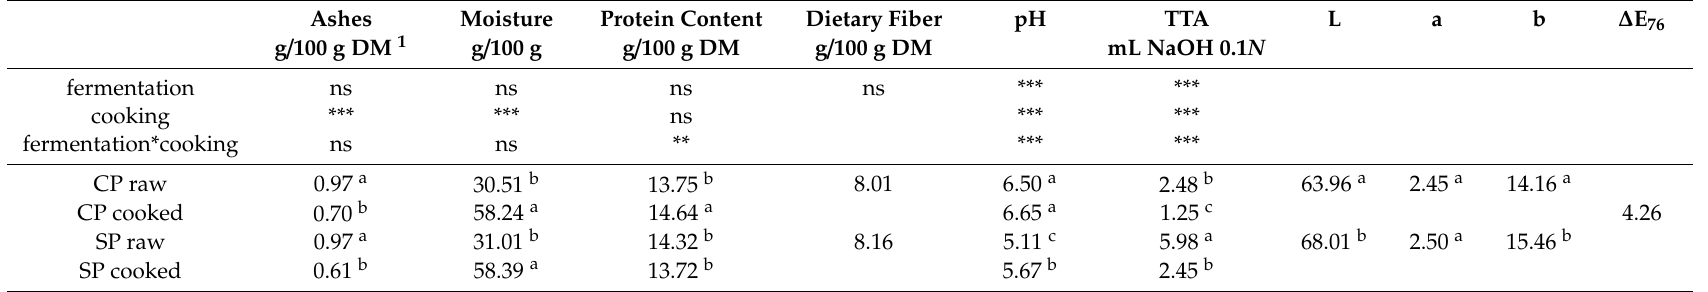
Table 1. Physicochemical parameters of pasta. CP, control pasta; SP, pasta with sourdough. Mean values are